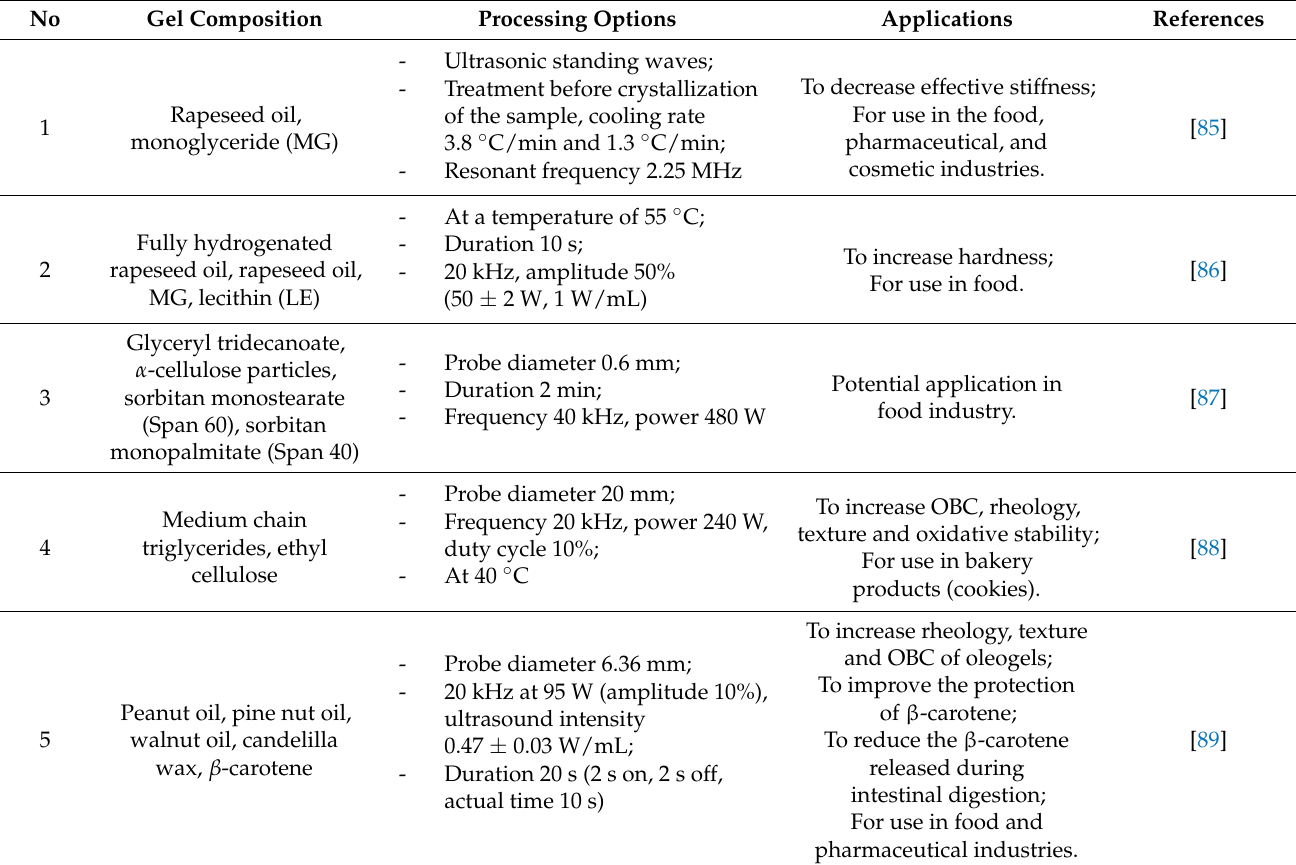
Table 1. Application of ultrasonic treatment to produce